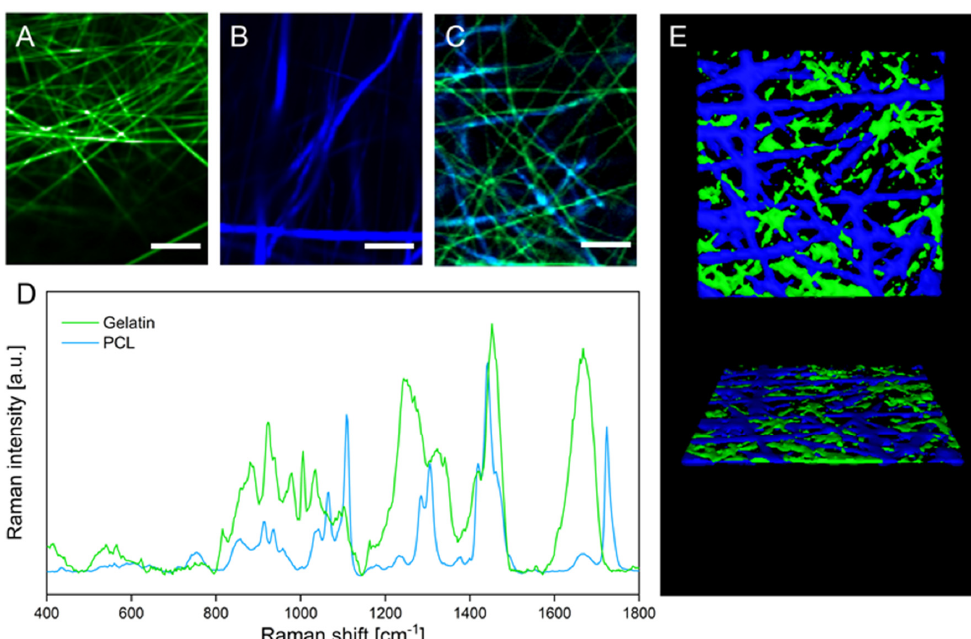
Figure 2. ( A – C ) False-color Raman images of gelatin ( A ), PCL ( B ), and hybrid ( C ) scaffolds. ( D ) Raman spectra of gelatin and PCL fibers. ( E ) 3D rendering of confocal Z-stack Raman images visualizing the three-dimensional organization of gelatin and PCL fibers within the hybrid scaffold. Scale bars represent 10 µm.